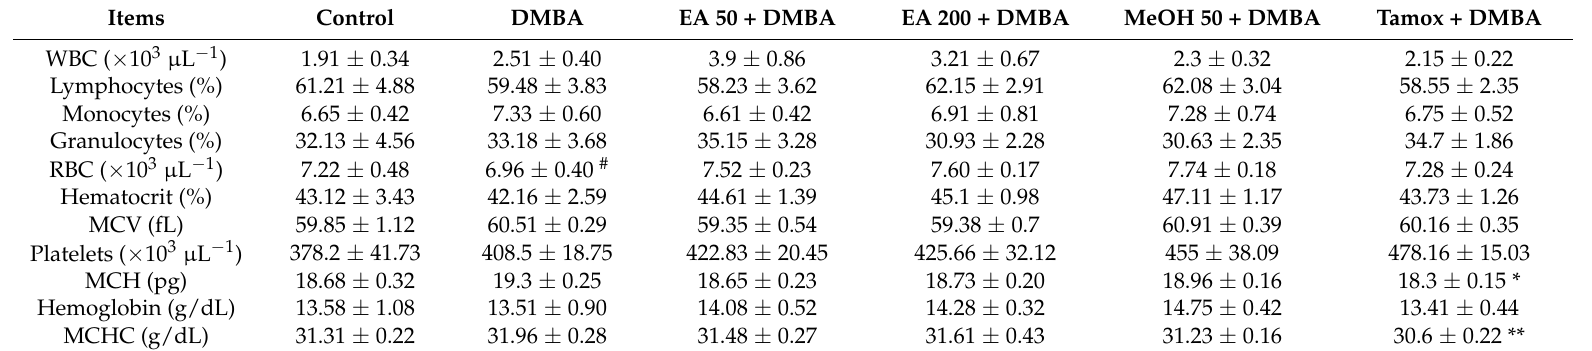
Table 6. Effects of F. umbellata extracts on hematological parameters after 20 weeks of